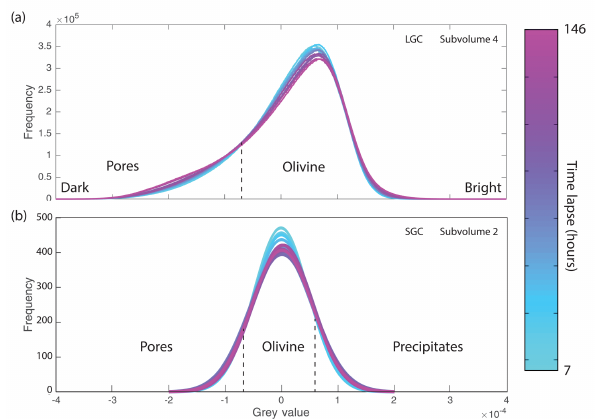
Figure 7. Best fits for the grey value distribution histograms of the sample at different stages of the reaction in (a) subvolume 4 from LGC sample and (b) subvolume 2 from SGC sample. Different col- ors represent time lapses as shown. Pores, olivine and precipitates are identified based on their grey value ranges. Higher values cor- respond to lighter grey (solids). The more negative a value is, the darker the grey color becomes (e.g., pores are black). Histograms of the SGC sample were calculated from a 2-D image (Zhu et al., 2016), whereas the histograms of the LGC sample were calculated from 3-D datasets.